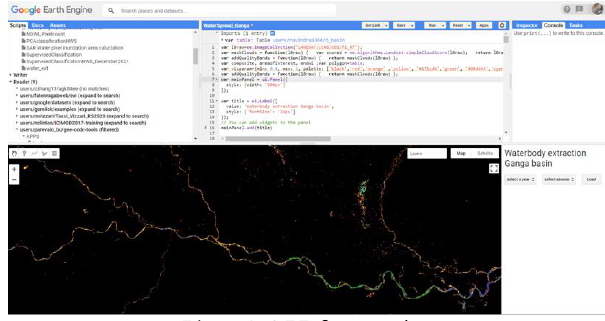
Figure 2. GEE framework